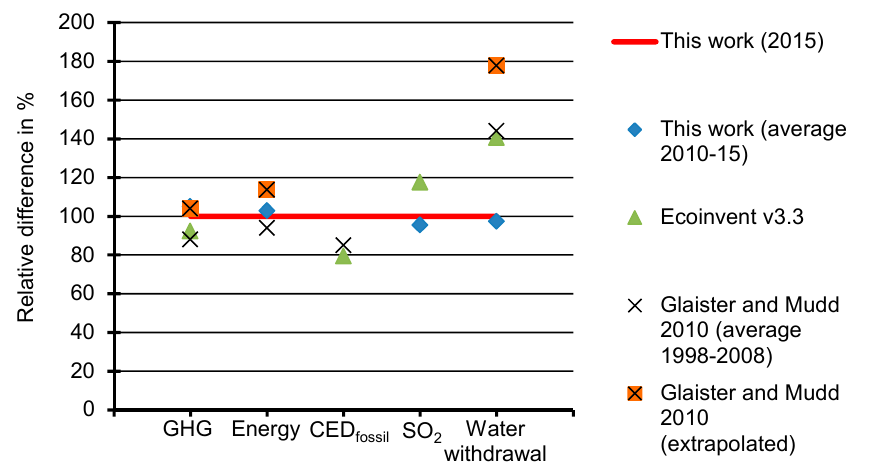
Figure 13. Comparison of GHG emissions, energy demand, CED fossil , SO 2 emissions and water withdrawal. Results are compared to reported values of Glaister and Mudd [6] and the Ecoinvent database [7,100]. Data and assumptions can be found in the Supplementary Materials (Table S3).